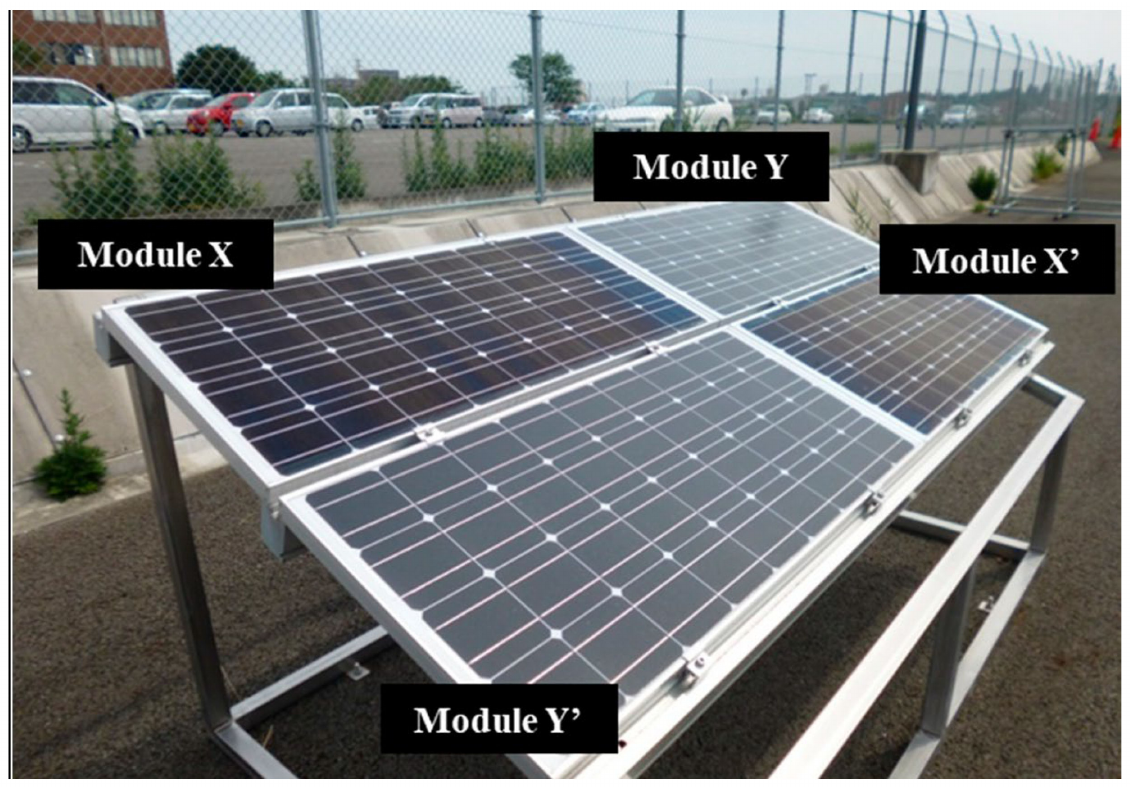
Figure 9. The surface of silicon PV modules. Two modules were coated (modules X and X’) and the other two modules were not coated to act as references (modules Y and Y’)